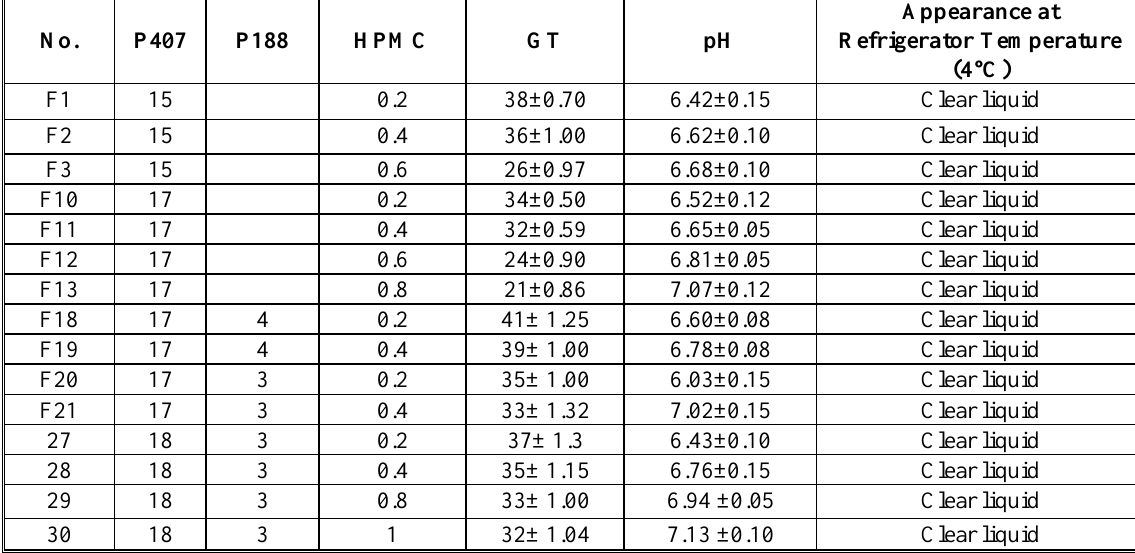
Table 2. A gelation temperature GT, appearance, pH of the formulated SC periodontal in-situ gel with HPMC as mucoadhesive